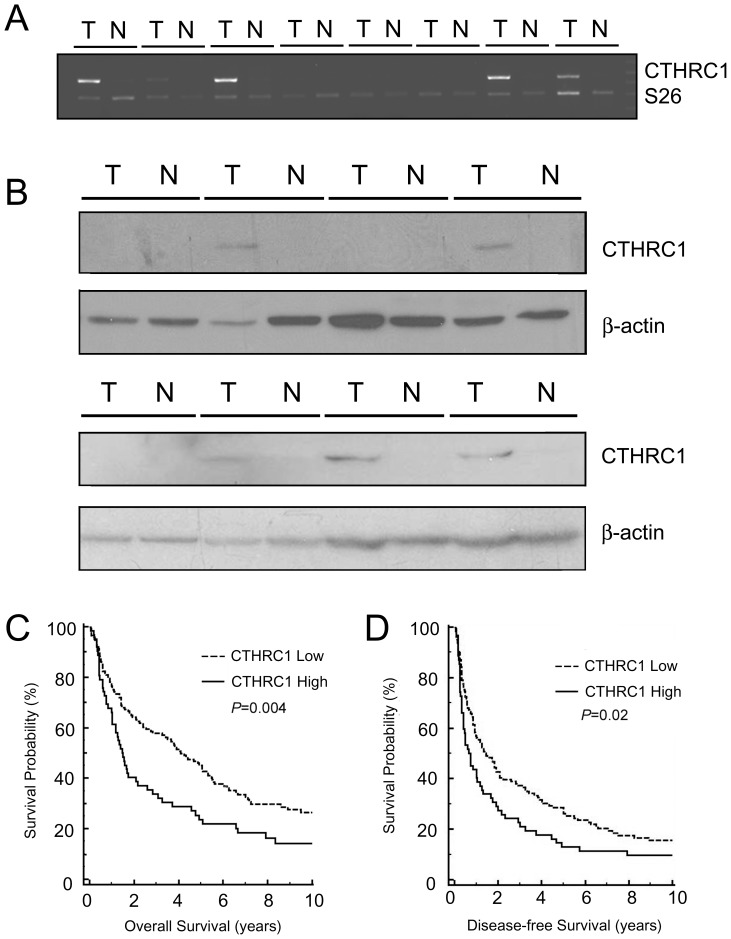
Overexpression of CTHRC1 in HCC.(A) RT-PCR analysis showed overexpression of CTHRC1 in 4 of 8 HCC specimens (T), but in none of the 8 specimens of nontumorous liver parenchyma (N). S26 (ribosomal protein S26) served as internal control. (B) Western blotting showed CTHRC1 was expressed in 5 of 8 HCC specimens (T) but not in nontumourous liver parenchyma (N). (C, D) Cumulative overall (C) and disease-free (D) survival curves for 201 patients with resected, unifocal, primary HCC stratified by CTHRC1 mRNA expression level as determined by real time RT-PCR. Patients with HCCs overexpressing the CTHRC1 gene had significantly lower 10-year overall and disease-free survival rates than those with HCCs without CTHRC1 overexpression.